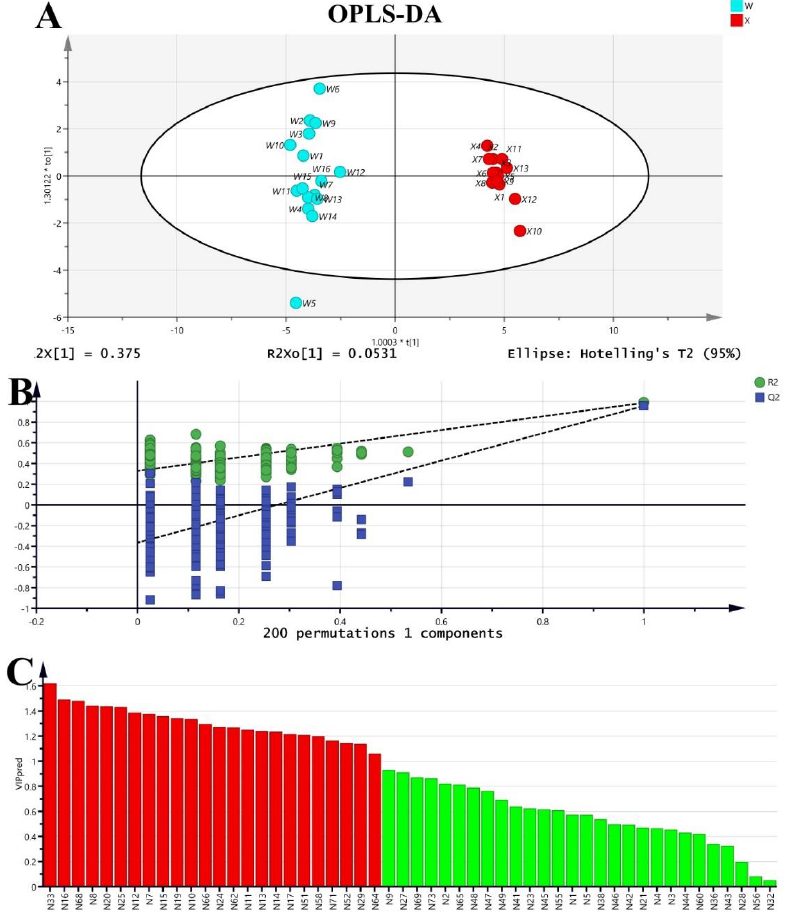
Figure 5. OPLS-DA model of Acanthopanacis Cortex (W) and Periplocae Cortex (X) based on GC-MS data. ( A ) OPLS-DA model; ( B ) 200 permutation tests; ( C ) identification of key VOCs by OPLS-VIP. The horizontal coordinate number was corresponding to Table 1; red indicated volatile aroma compounds with VIP value greater than 1; green indicated volatile aroma compounds with VIP value less than 1.